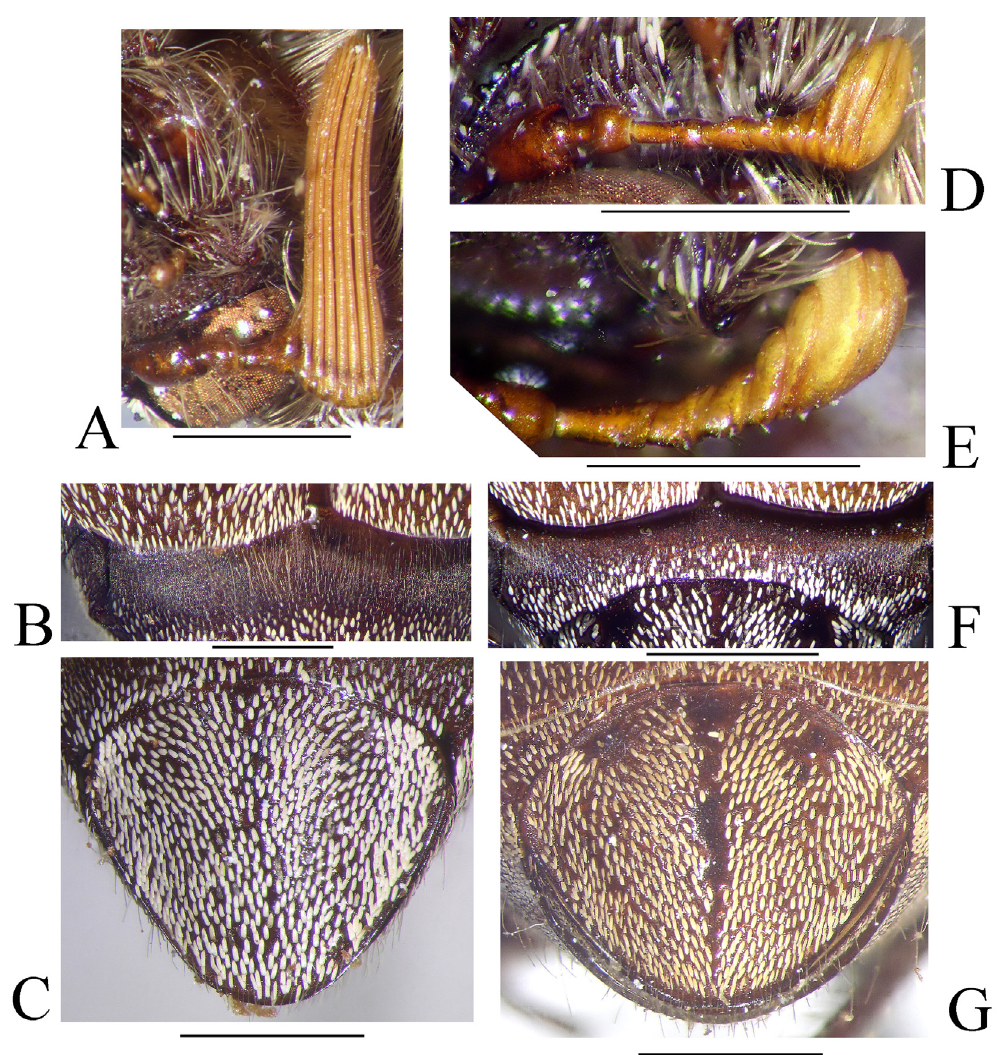
Fig. 4. Philacelota leucothea sp. nov., holotype, ♂ (MNHN) (A–C) and paratype, ♀ (MNHN) (D– G). A . Antenna, lateral view. B . Propygidium. C . Pygidium. D . Antenna, lateral view. E . Antenna, dorsolateral view showing relative size of club antennomeres. F . Propygidium. G . Pygidium. Scale bars: A, C–E = 1.5 mm; B = 2 mm; F–G = 2.5